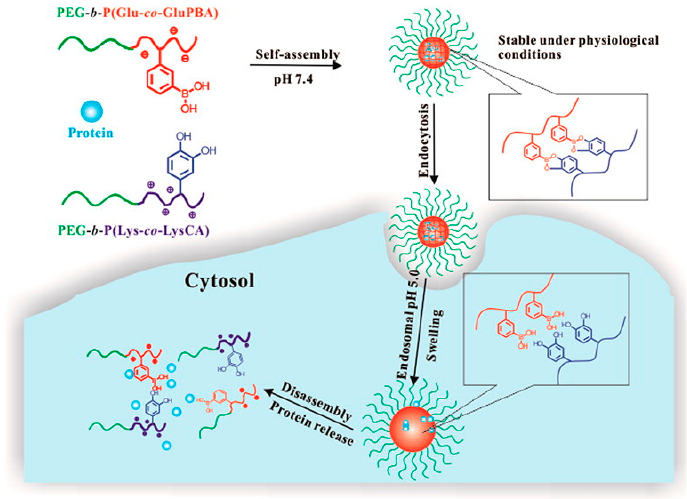
Figure 7. Schematic representation of a protein-loaded core-cross-linked micelle through boronate ester-catechol complex formation and subsequent intracellular protein delivery triggered by endosomal pH [61]. Copyright 2013 American Chemical